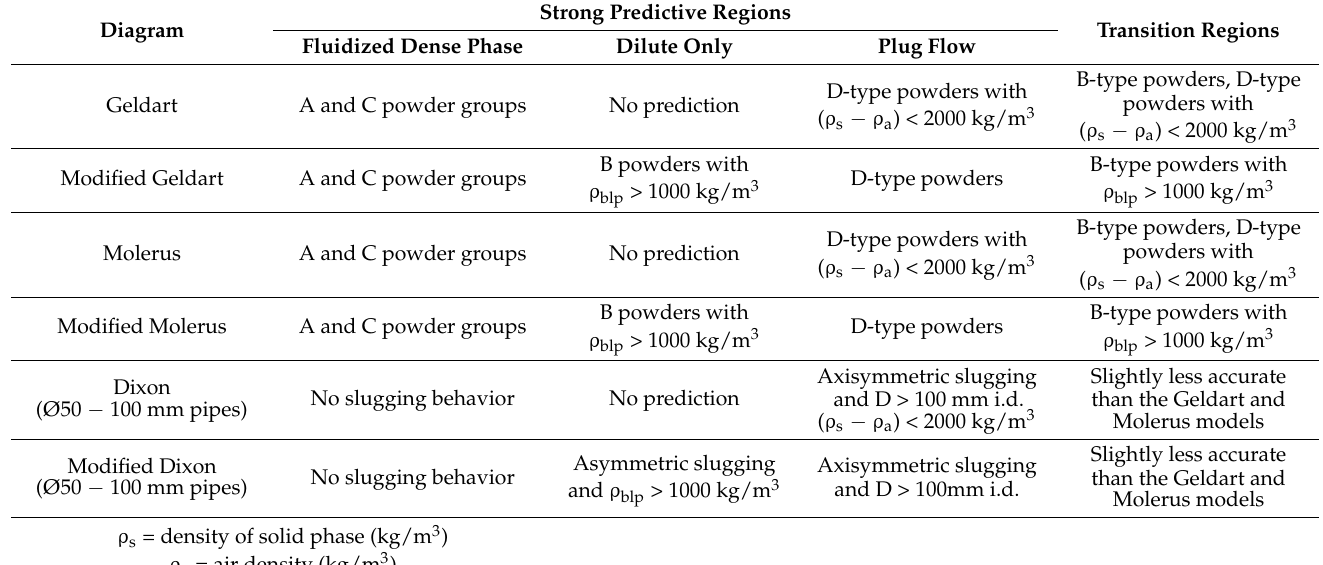
Table 2. Summary of mode of flow predictive capability of basic bulk material diagrams [30].